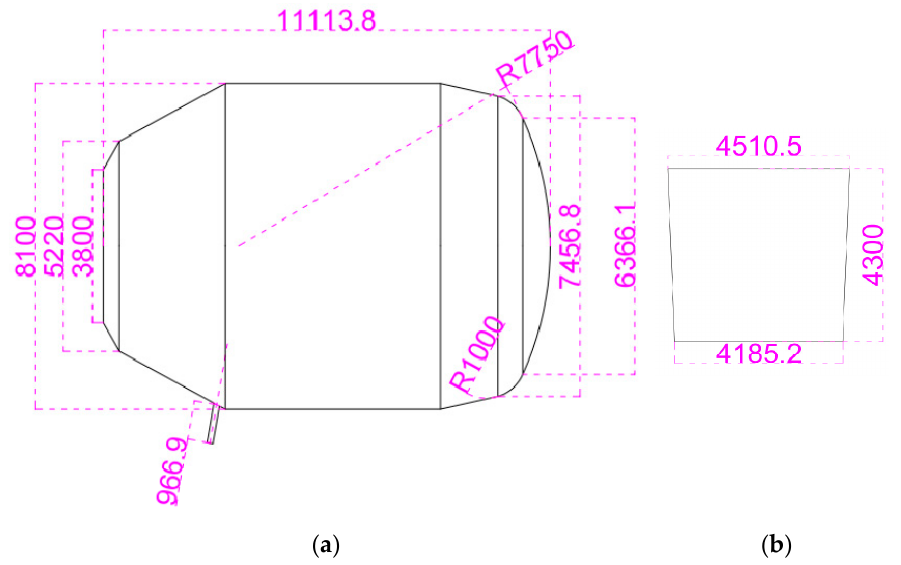
Figure 1. Geometric of the ( a ) converter; ( b ) ladle.